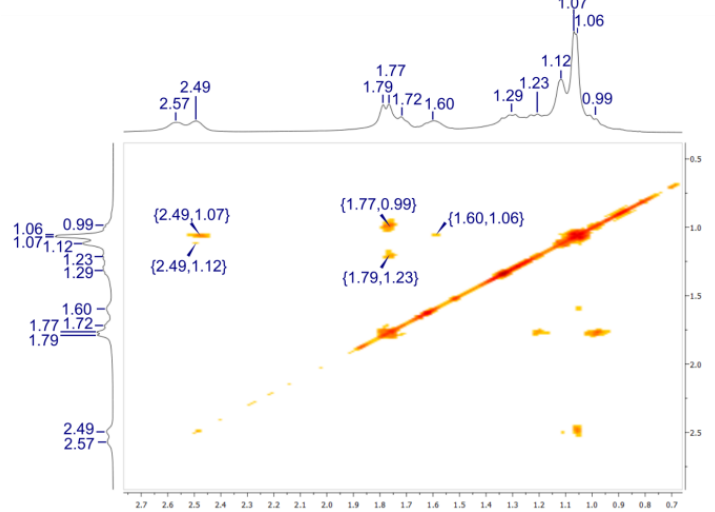
Figure 3. Fragment of 1 H– 1 H COSY NMR spectrum of 2 in pyridine- d 5 .